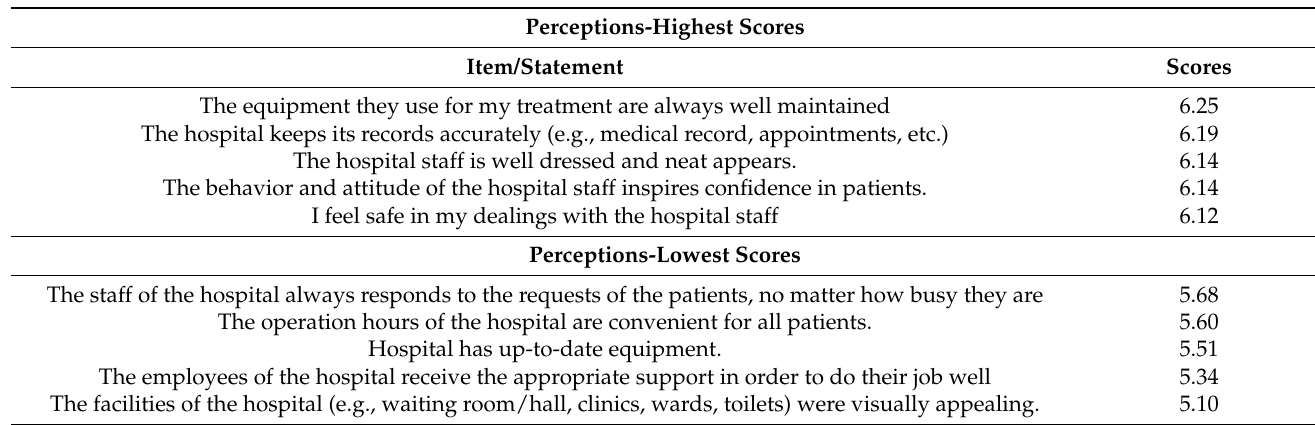
Table 5. Statements with the highest and lowest scores on Perceptions.